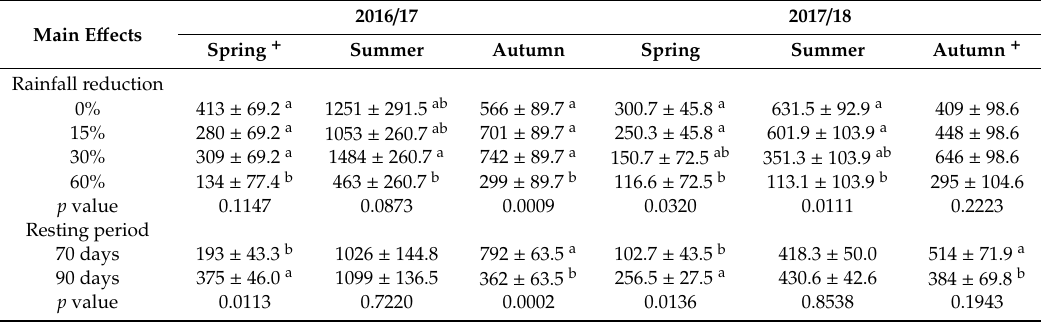
Table 7. Main e ff ect of resting period and rainfall reduction on increaser grass (mean ± S.E) species (kg.ha − 1